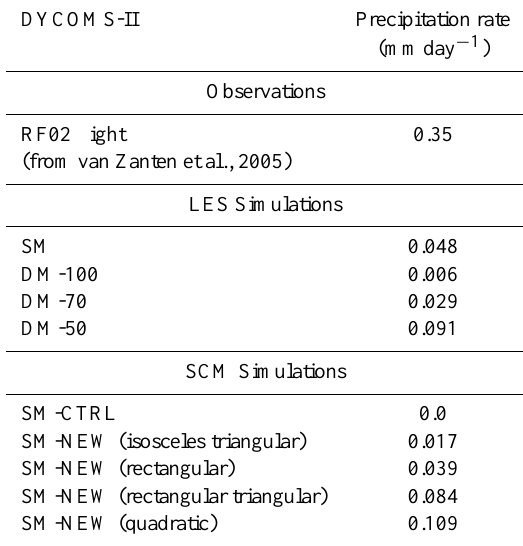
Table 4. Observed and simulated surface precipitation rates for